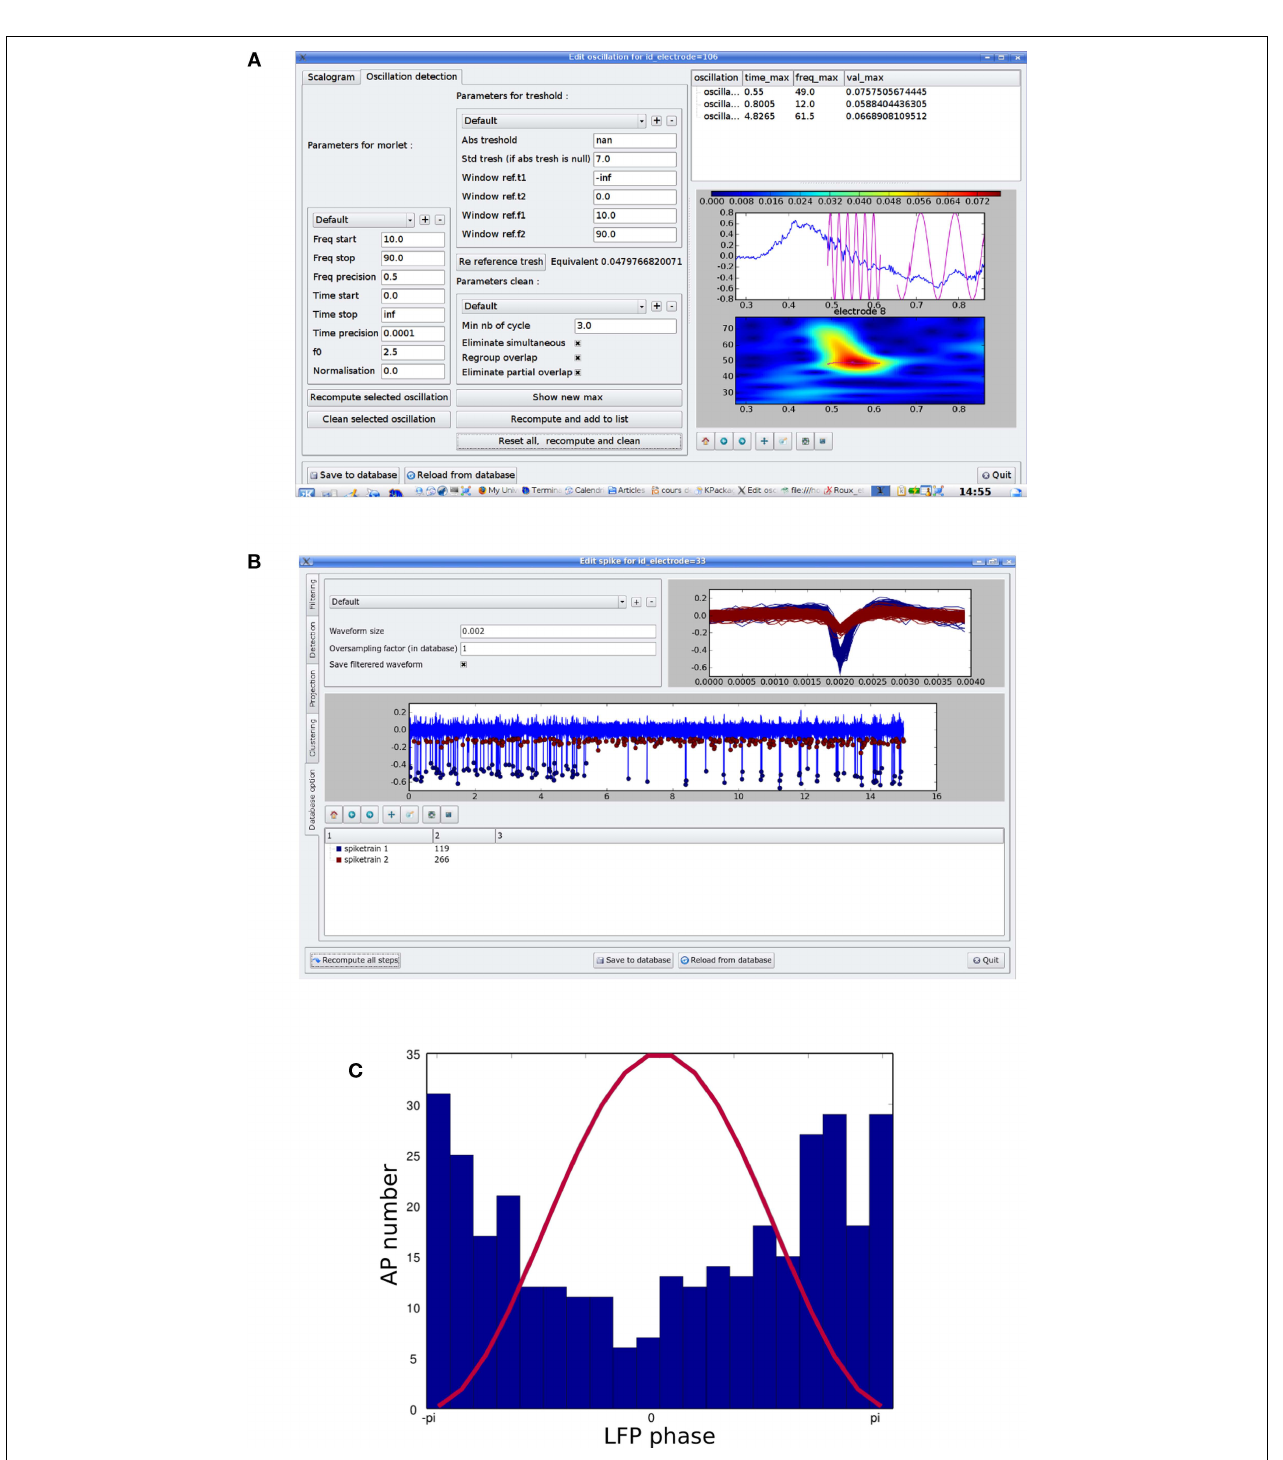
detection dialog. On the left, there are different tabs corresponding to the different steps of spike extraction: fi ltering, detection, projection and clustering. The result of a particular detection that can be saved into the database is on the shown tab. (C) Example of how spike and oscillatory events can be mixed, showing how a spike train is phase locked on the LFP phase. One oscillation cycle is depicted in red, and a histogram of the phases of spike discharge is shown in